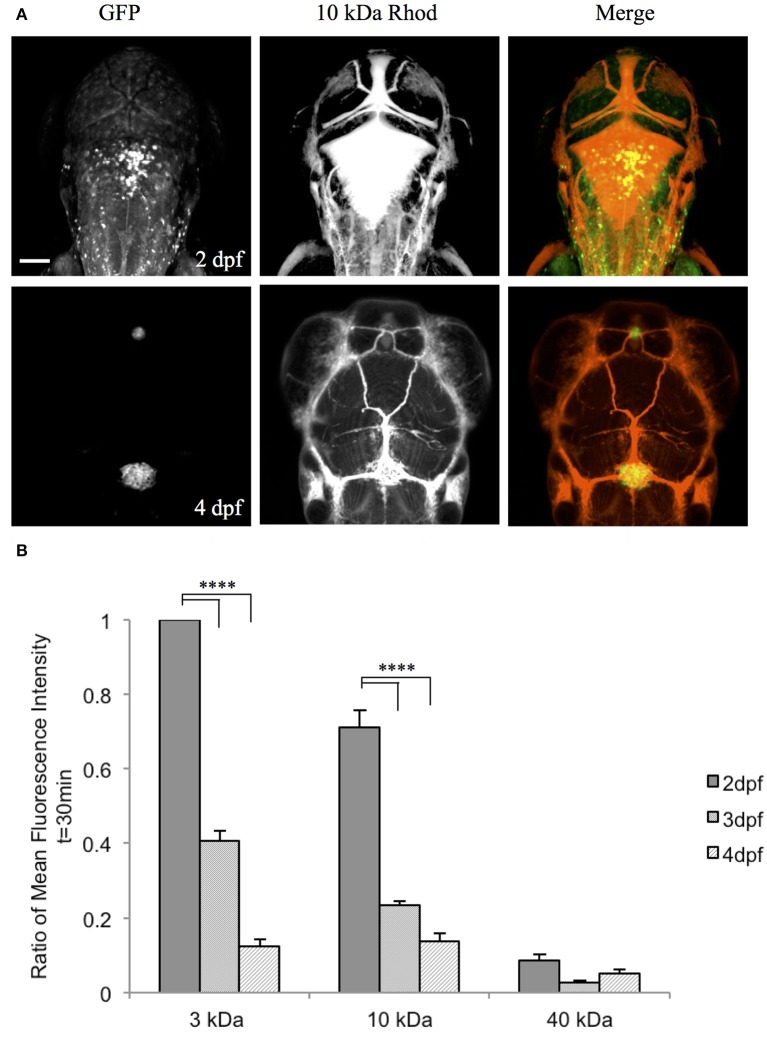
The zebrafish CP becomes size-selective as it develops. (A)
Et(cp:EGFP)sj2 larvae were intravenously injected with a 10 kDa rhodamine-dextran and the CP was imaged dorsally by confocal microscopy. At 2 dpf, the CP is not fully developed as observed by GFP expression and the 10 kDa rhodamine-dextran inundates the brain ventricle. By 4 dpf, the CP is fully formed and the 10 kDa rhodamine-dextran is retained within the vasculature and does not enter the brain ventricle. (B) A One-Way ANOVA analysis revealed that the 3 kDa fluorescein dextran and 10 kDa rhodamine dextran have a significantly higher fluorescent intensity in the brain ventricle (i.e., more permeable) at 2 dpf compared to 3 and 4 dpf. There is no significant difference between developmental time points for the 40 kDa fluorescein dextran. Measurements are means ± SE for n = 7; ****p < 0.0001. Scale bar is 50 μm.